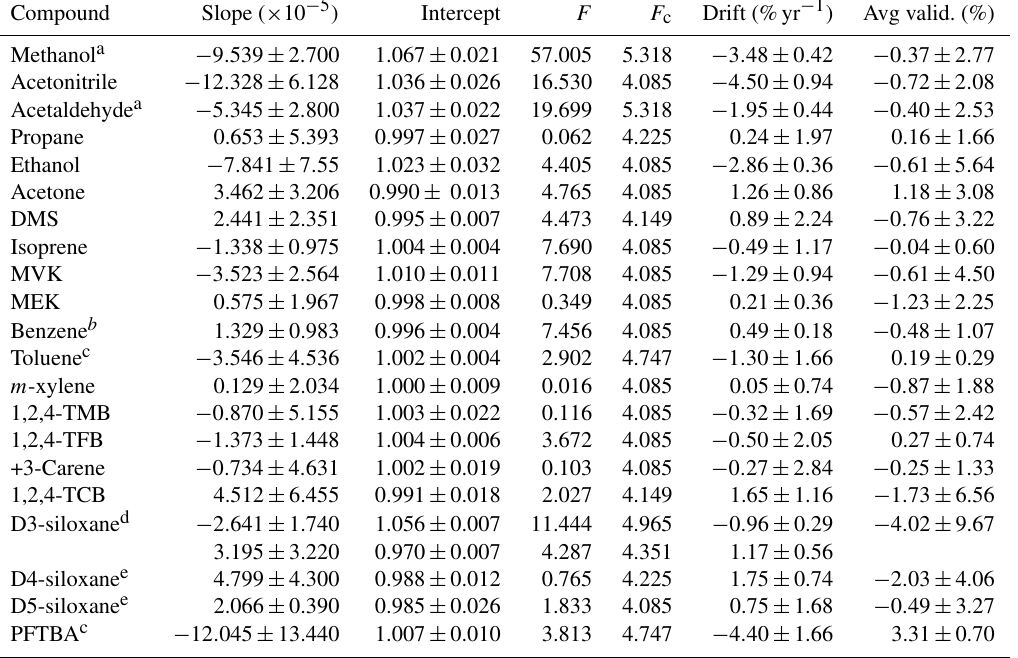
Table 3. Summary of the results of the least-squares straight-line regression analysis for all stability data shown in Figs. 3 and S2. Results are shown for the slope ( ± 2 σ) , intercept ( ± 2 σ ), ANOVA test statistics ( F and F c ) used to evaluate the presence of a statistically significant trend ( F > F c ), the calculated annual drift ( ± 2 σ ) determined from the linear fit, and the average of the validation data ( ± 2 σ ), also shown in Fig.